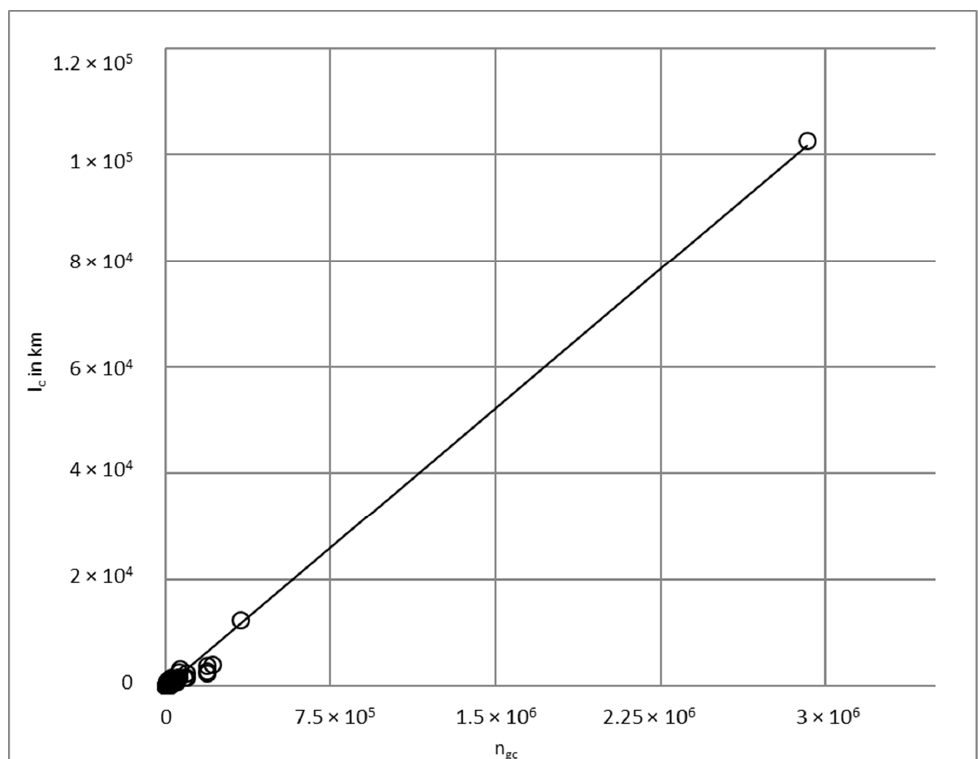
Energies 2019 , 12 , x FOR PEER REVIEW 12 of 26 Equally, the relationship between the number of grid connection points n gc and the cable length per DSO l c is extraordinary according to the correlation analysis. Usually grid interconnectors are distributed homogenously across the cable length, which implies that with growing cable length the number of interconnectors should increase. This however is not the case here, as illustrated in Figure 4. Figure 3. Plot of W na versus D po with linear regression line. Figure 3. Plot of W na versus D po with linear regression line.